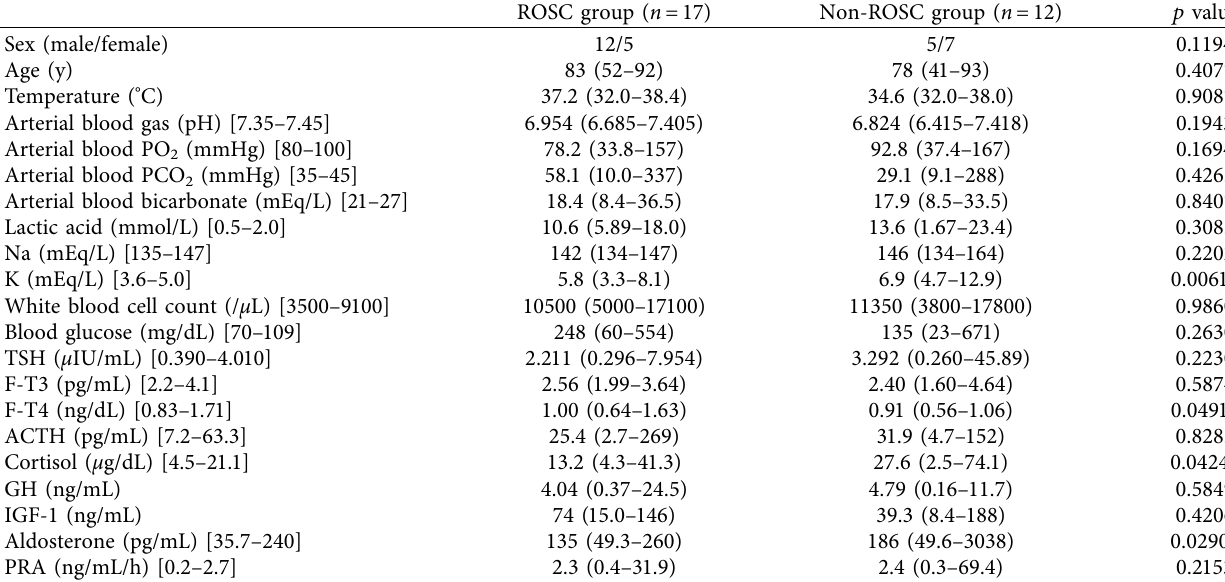
Table 1: Comparison between the ROSC and non-ROSC groups.